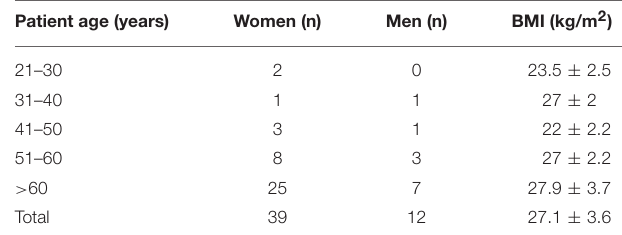
TABLE 1 | Baseline characteristics of the patient